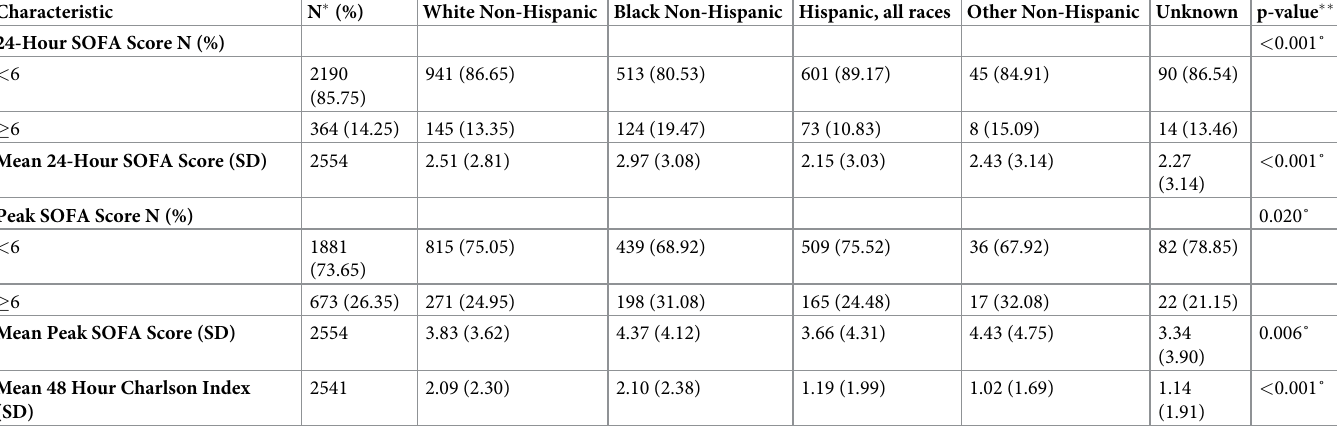
Table 2. Distribution of clinical characteristics in COVID+ patients by race/ethnicity, n = 2554. Characteristic